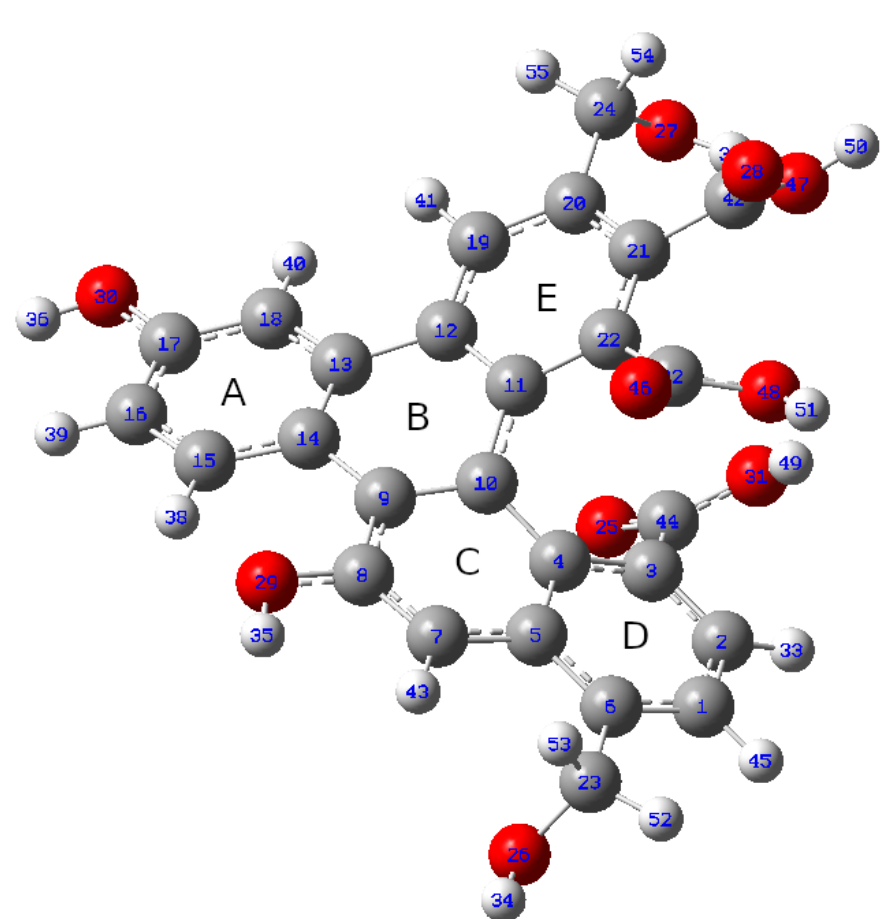
Figure 4. Optimized geometry of bare UFQD at ω -B97XD/6-31+G(d) level. Carbon: gray; hydrogen: white; oxygen: